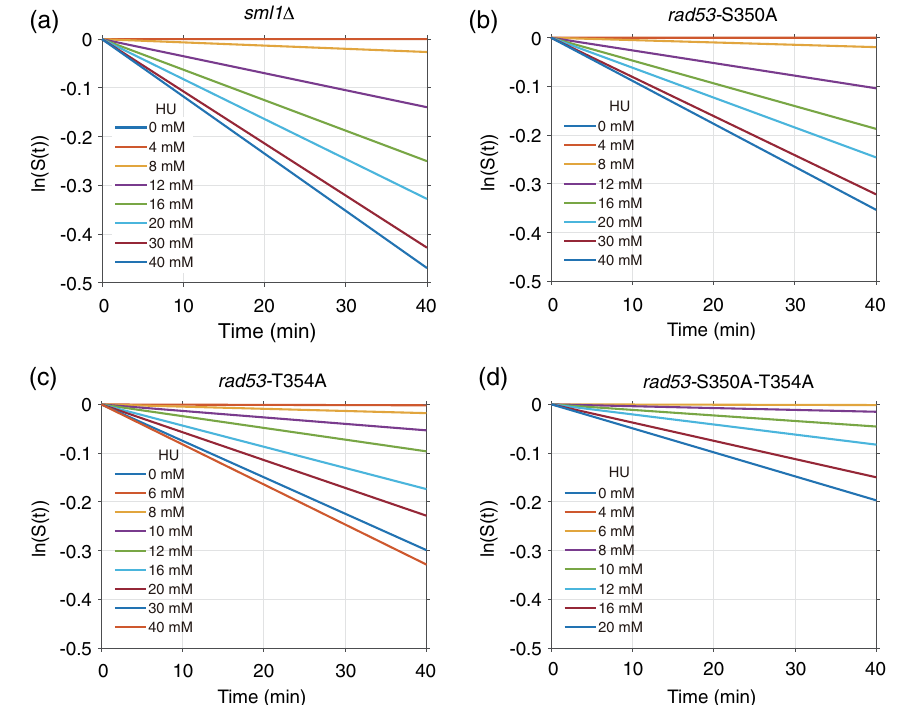
FIG. 9. The theoretical switch time τ n (cid:3) follows the exponential distribution for sml 1 Δ (a), S350A (b), rad 53 -T 354 A (c), and i (cid:3) rad 53 -S 350 A-T 354 A (d) strains. X label: time (min). Y label: logarithm of survival probability.